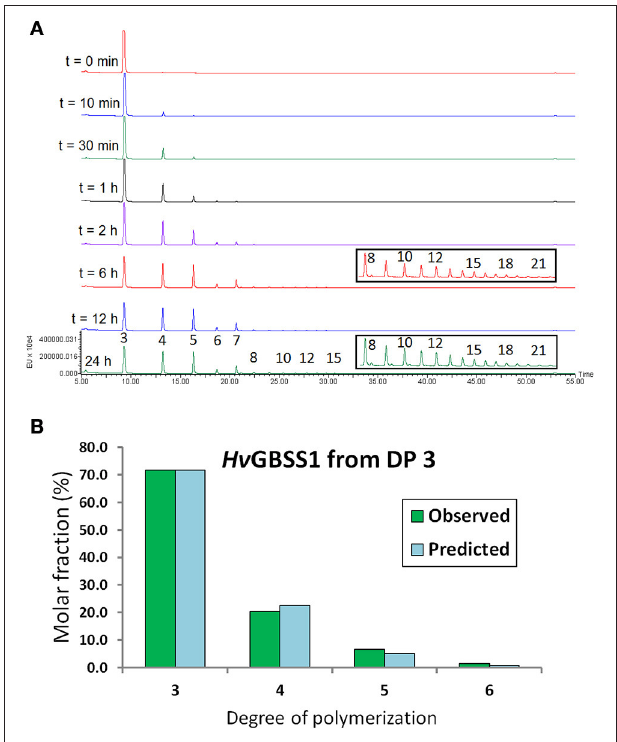
FIGURE 3 | Observed and predicted reaction course for Hv GBSSI action on maltotriose. (A) UPLC traces of reaction of GBSSI with unlabeled maltotriose. DPs of product and time points are indicated. Labeling was done after reaction termination. The DP = 3 peak is truncated in all traces up to 2h for improved visibility of the other peaks. Boxes contain the traces for the larger peaks with a zoomed in vertical scale to illustrate the relative areas of peaks up to DP = 21, some peaks with even larger DPs are visible. (B) Observed (green bars) and predicted (blue bars) product distributions corresponding to the reaction progress after 6h, before DP = 7 started to accumulate. The predicted product distribution was calculated assuming a purely distributive reaction mechanism and the individual reaction velocities for each acceptor measured at 37 ◦